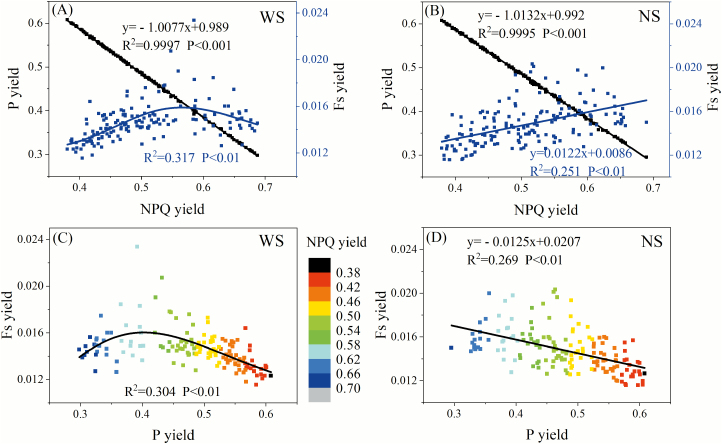
Relationships between Fs yield, P yield, and NPQ yield under low light conditions (PAR=100 μmol m–2 s–1). Blue symbols in (A) and (B) correspond to the right axis, and black symbols correspond to the left axis. The fit line and the corresponding equation are shown in the same color. Gradient colors in (C, D) denote the changes of NPQ yield.